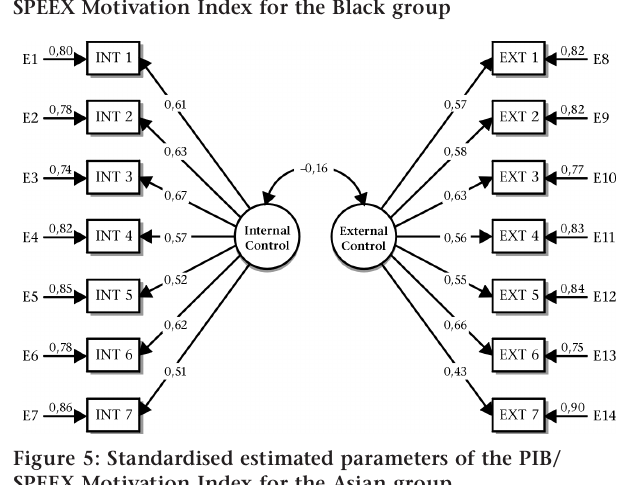
Figure 4: Standardised estimated parameters of the PIB/ SPEEX Motivation Index for the Black group